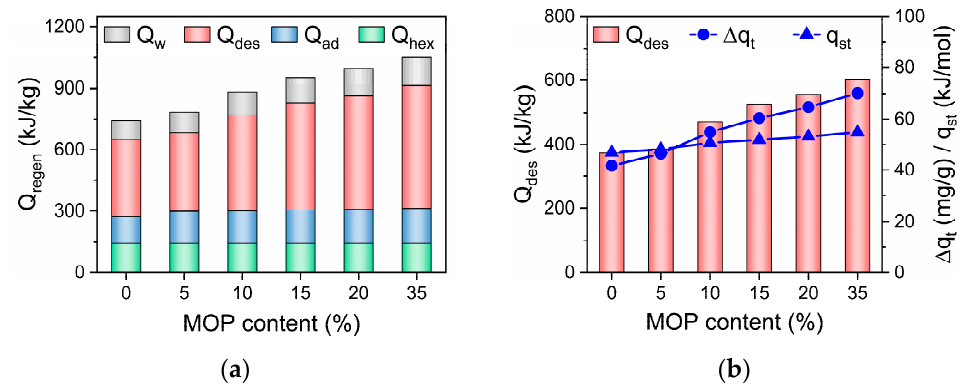
Figure 8. ( a ) Energy consumption for temperature rising of adsorbents (Q ad ), adsorbed water (Q w ), and heat exchanger (Q hex ) during the desorption process and energy consumption for water desorption (Q des ). ( b ) Relationship between cyclic working capacity ( Δ q t ), the heat of adsorption (q st ), and Q des of MOP/MIL-101(Cr) composites with different MOP 3 content.